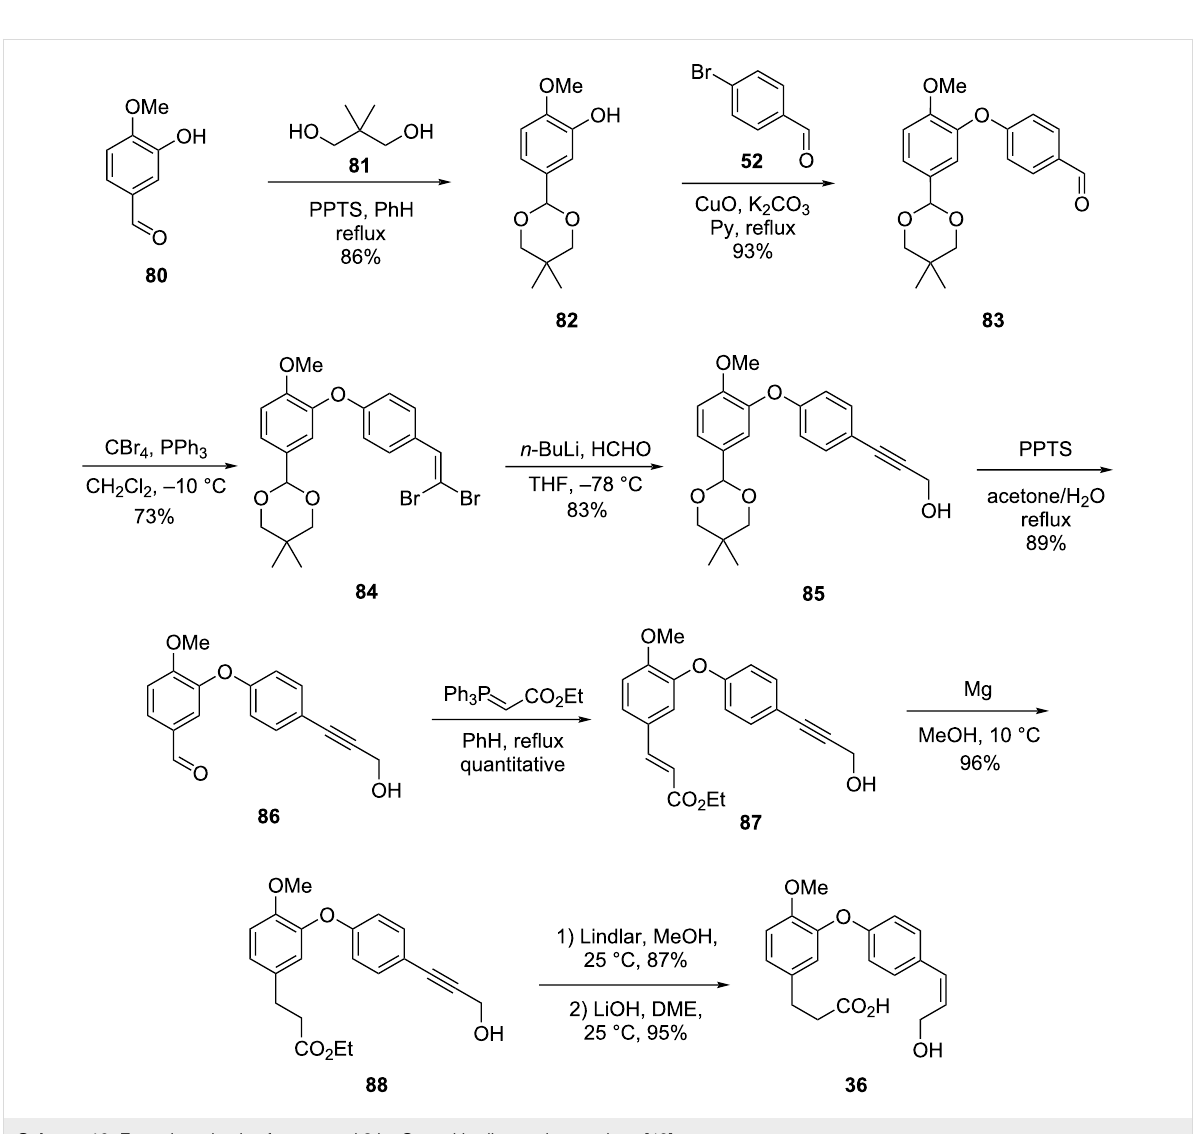
Scheme 16: Formal synthesis of compound 2 by Gangakhedkar and co-workers